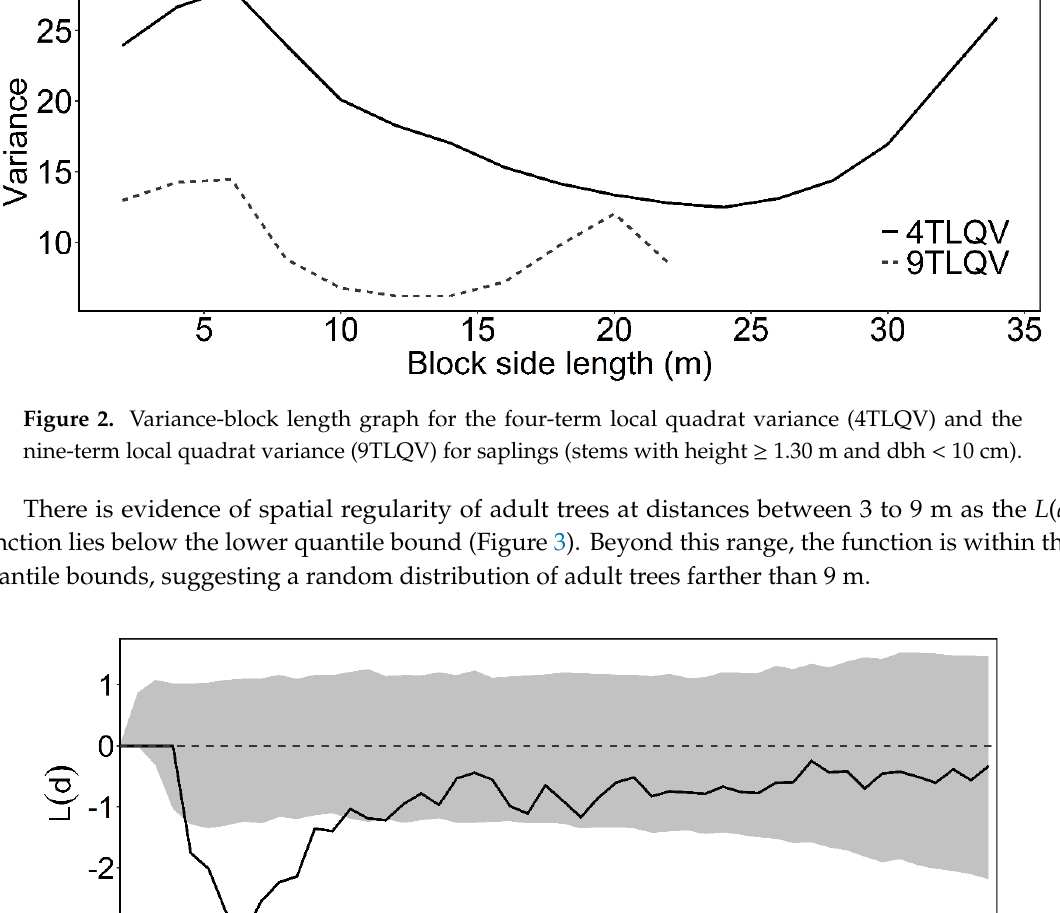
Figure 3. L ( d ) function (continuous line) for the pattern of the adult trees (stems with dbh ≥ 10 cm) and the 95% quantile bounds corresponding to the null model. Values of L ( d ) below the 95% quantile bounds indicate the spatial regularity of adult trees and values of L ( d ) above the 95% quantile bounds indicate clustering of adult trees.